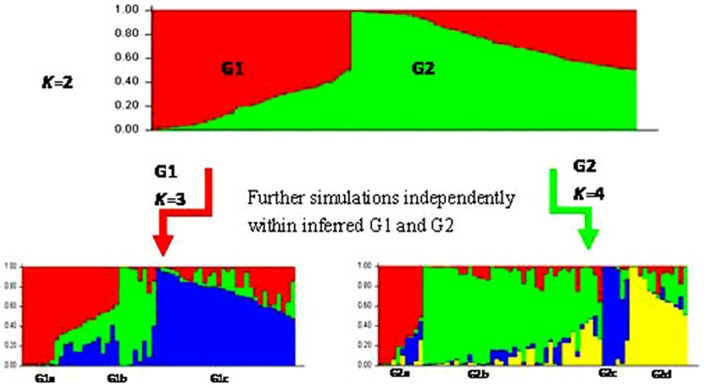
Relationship between the inferred populations.The two inferred clusters (k = 2) resulted from simulation using all 158 accessions in one and correspond to G1 and G2, respectively. Then three and four clusters (k = 3 and 4) were inferred within inferred G1 and G2 independently.